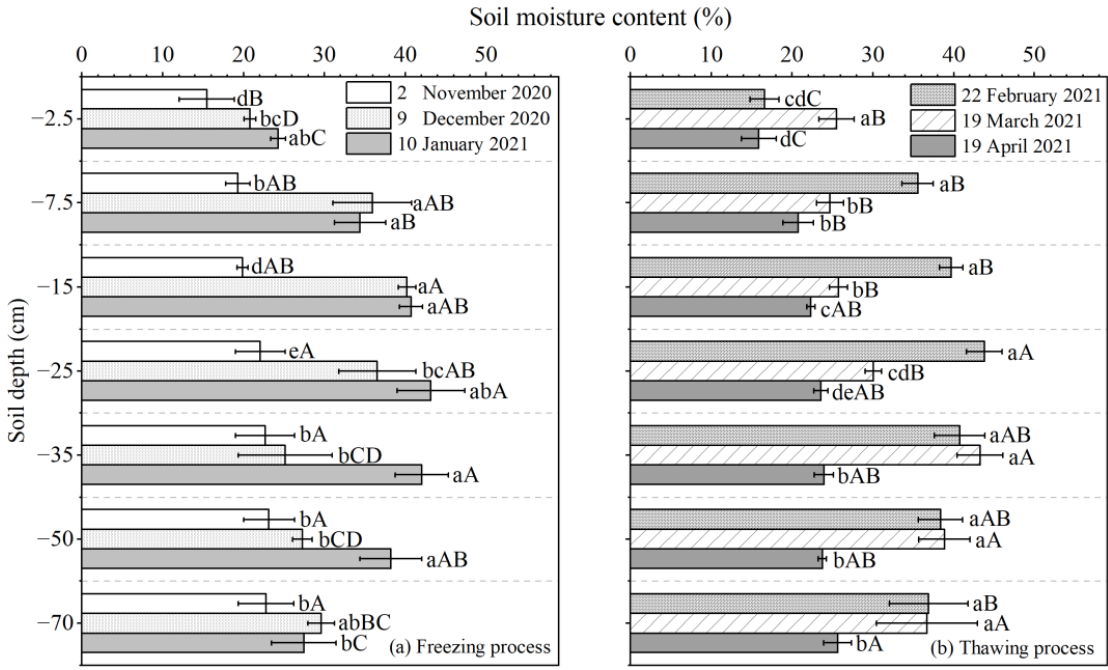
Figure 3. Changes in soil moisture content (SMC) during the freeze – thaw process. Note: Different lowercase letters indicate significant differences between different times ( p < 0.05). Different capital letters indicate significant differences between different soil layer ( p < 0.05). The horizontal line represents the S.D. of the average.